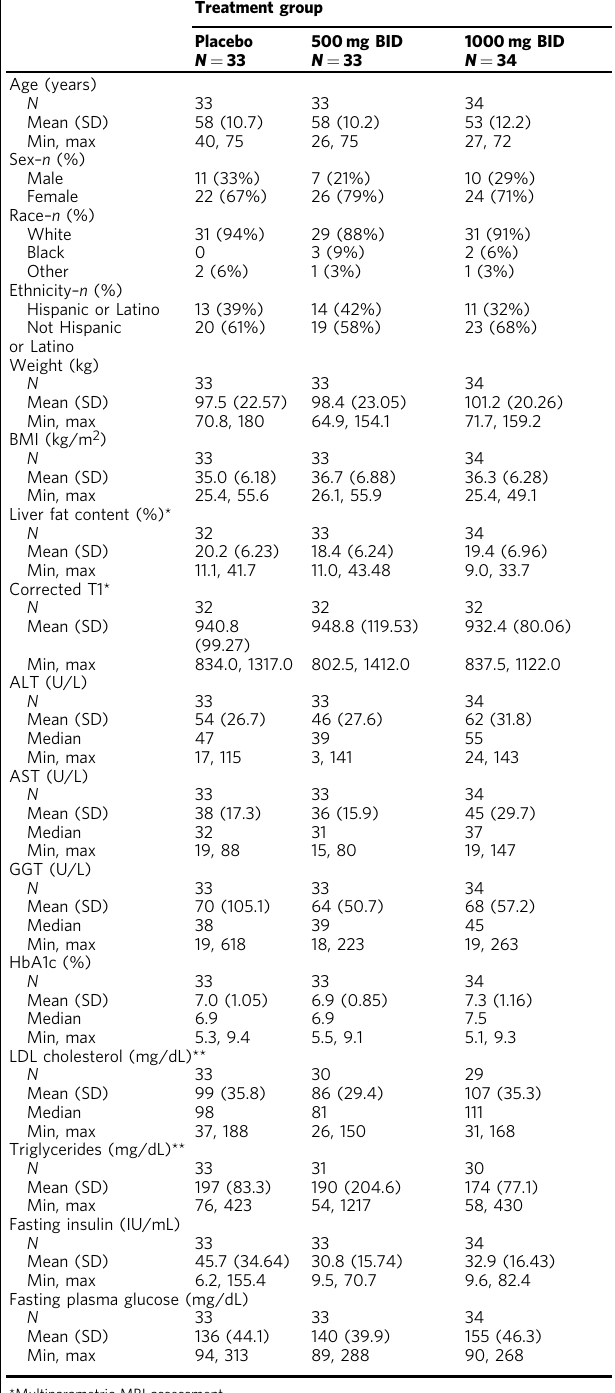
*Multiparametric MRI assessment. **Modi fi ed ef fi cacy